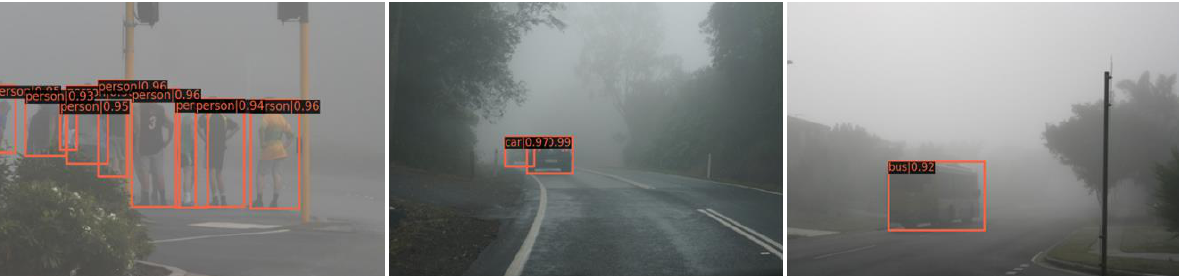
Figure 12. Visualization of the detection results obtained on the FLIR thermal dataset. Table 6. Experimental results on FLIR thermal dataset (the top three performances are highlighted in red, blue, and green, bold denotes our algorithm.).